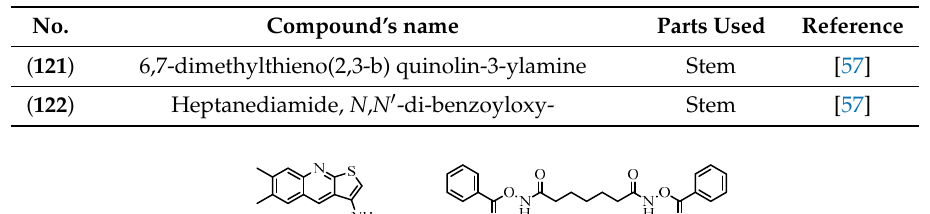
Figure 7. The structures of the alkaloids from A. cathartica .